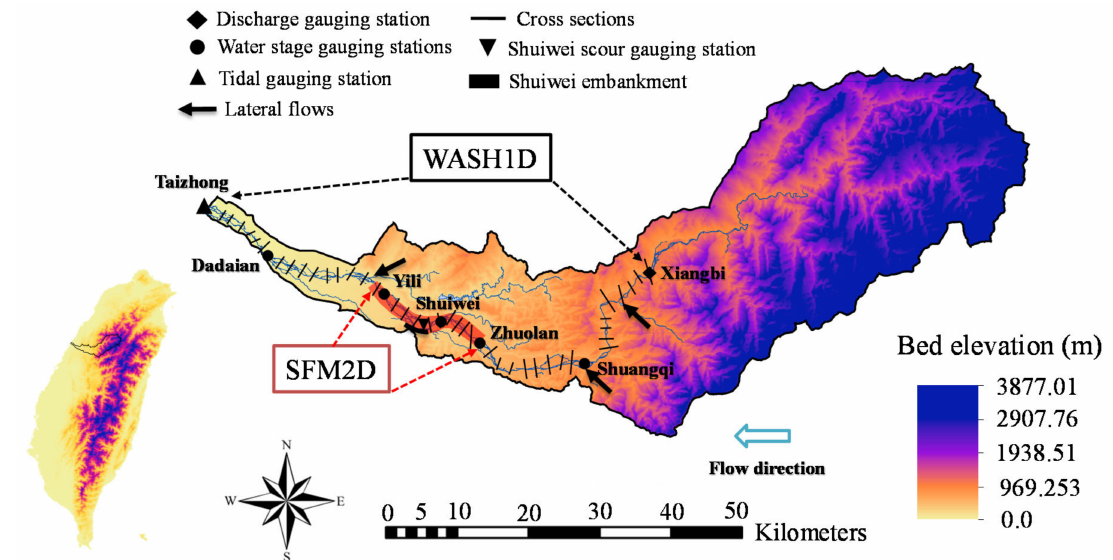
Figure 3. Location of this study site displaying the simulation domain of WASH1D and SFM2D.